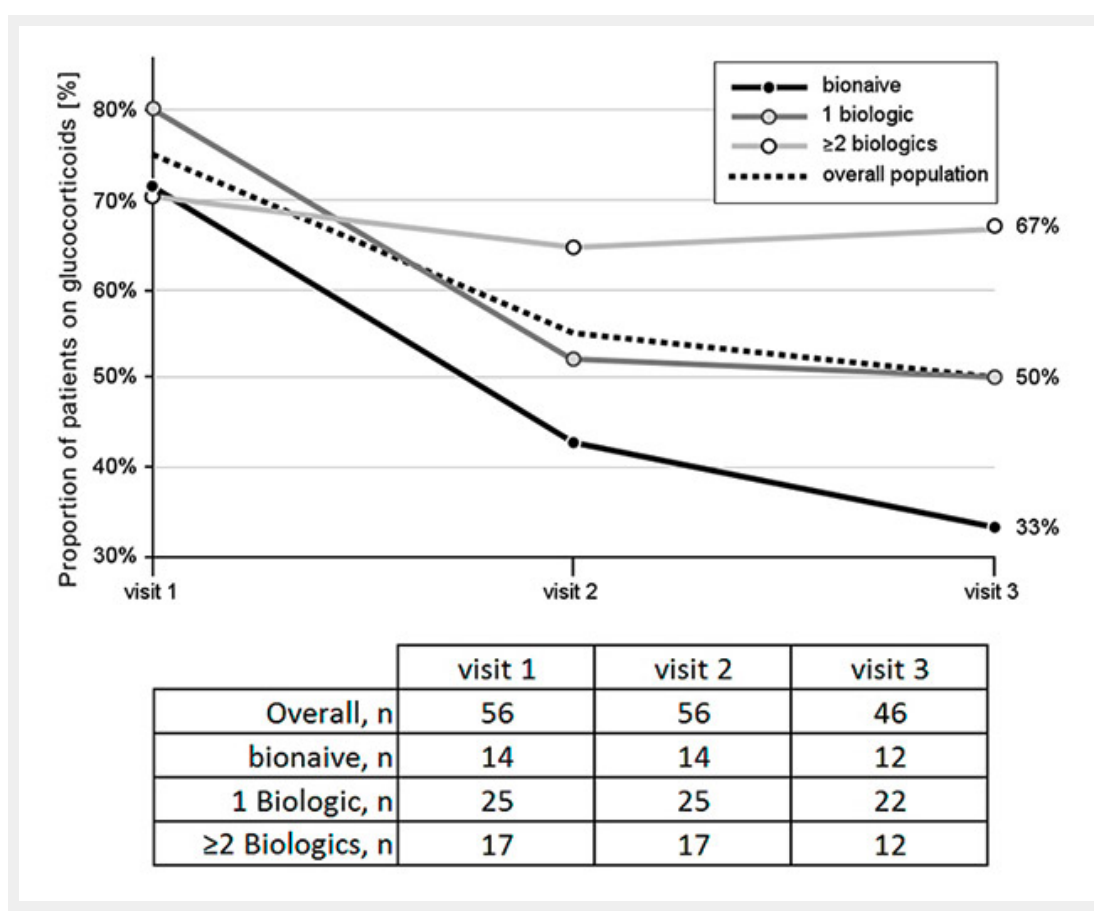
Figure 4 Glucocorticoid use over time: percentages of patients regularly taking glucocorticoids at the time of each visit. The numbers of patients with available information on glucocorticoid use at each visit are listed in the